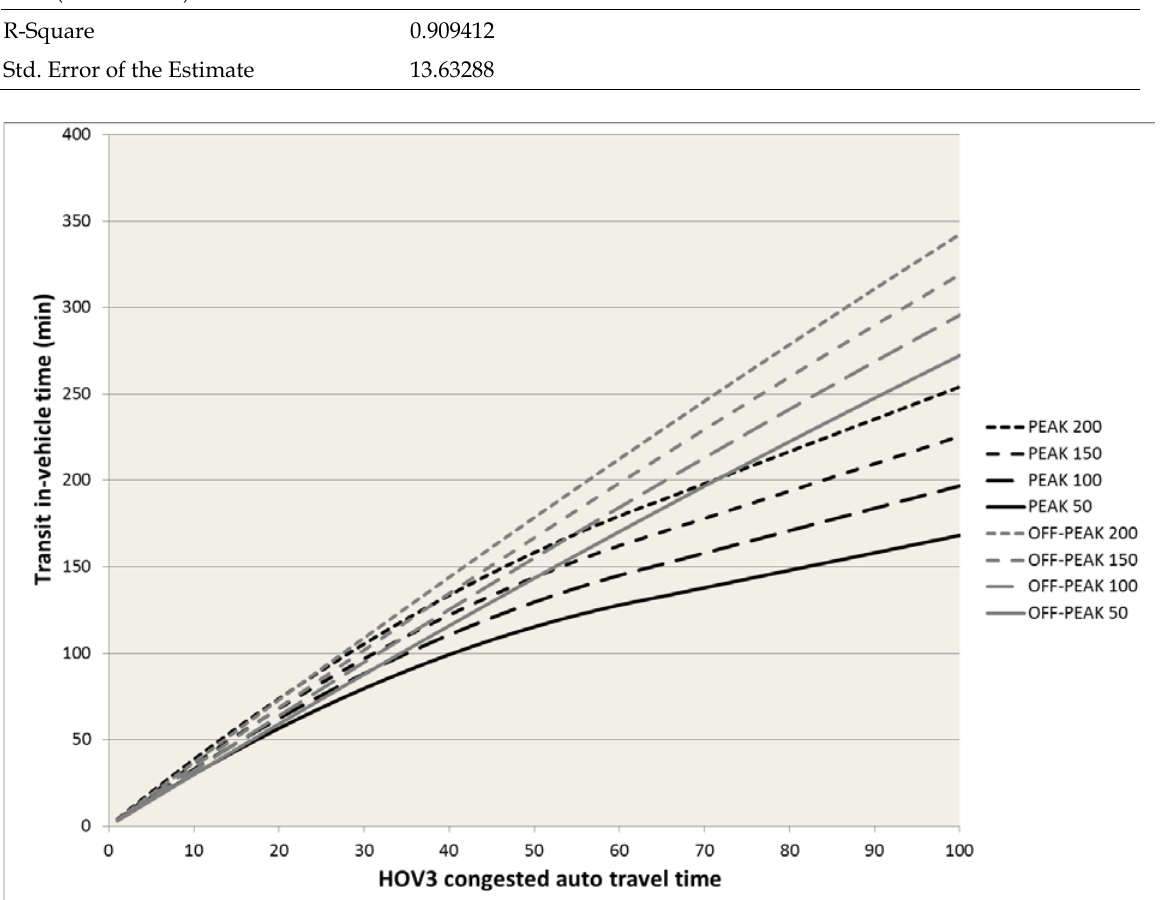
Figure 3. Transit In-Vehicle Time as a function of HOV3 congested auto travel time for Peak (in black) and Off-Peak (in gray) time, with different LOS